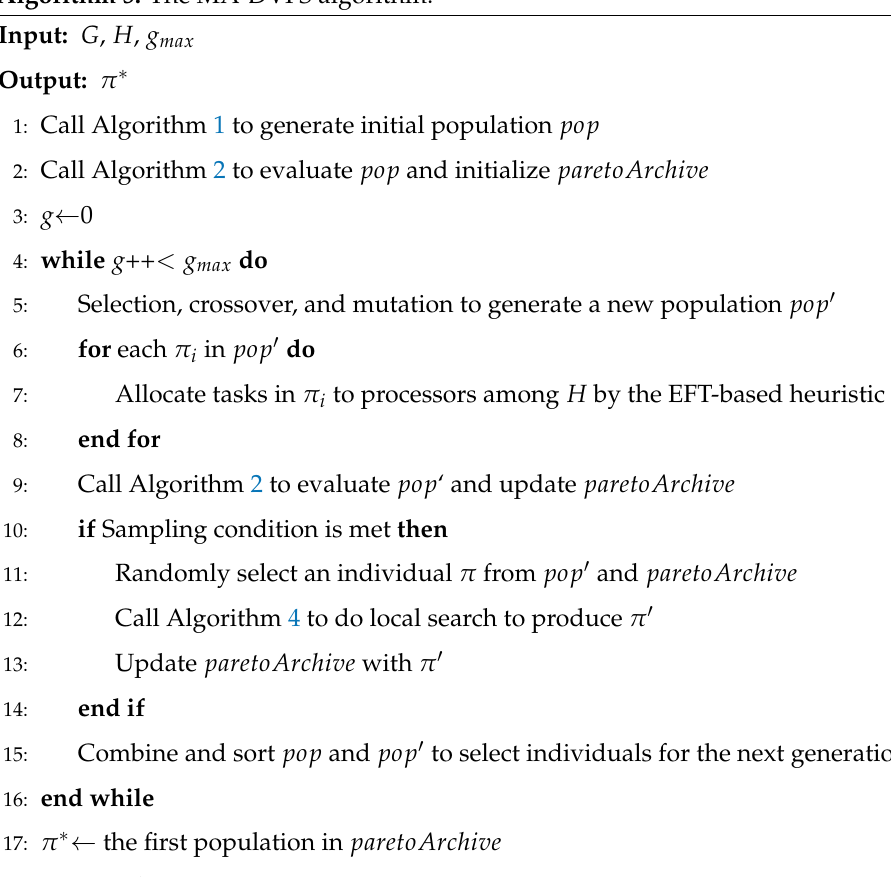
Algorithm 5. The MA-DVFS